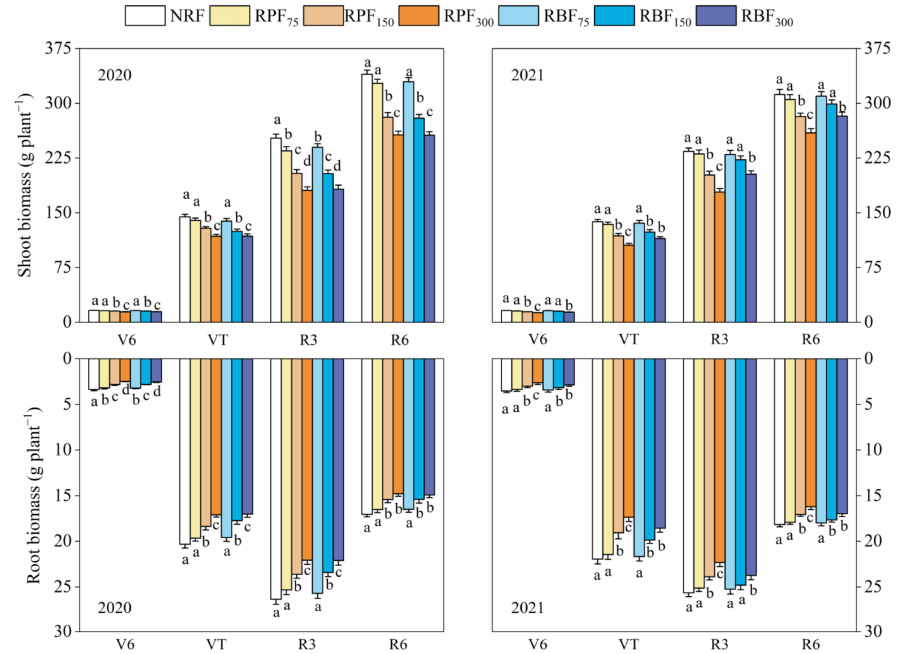
Figure 7. Dynamics of shoot and root biomass in response to the different treatments in 2020 and 2021 spring maize growing seasons. Vertical bars represent the standard error of the mean. The different lowercase letters are significantly different at p < 0.05.